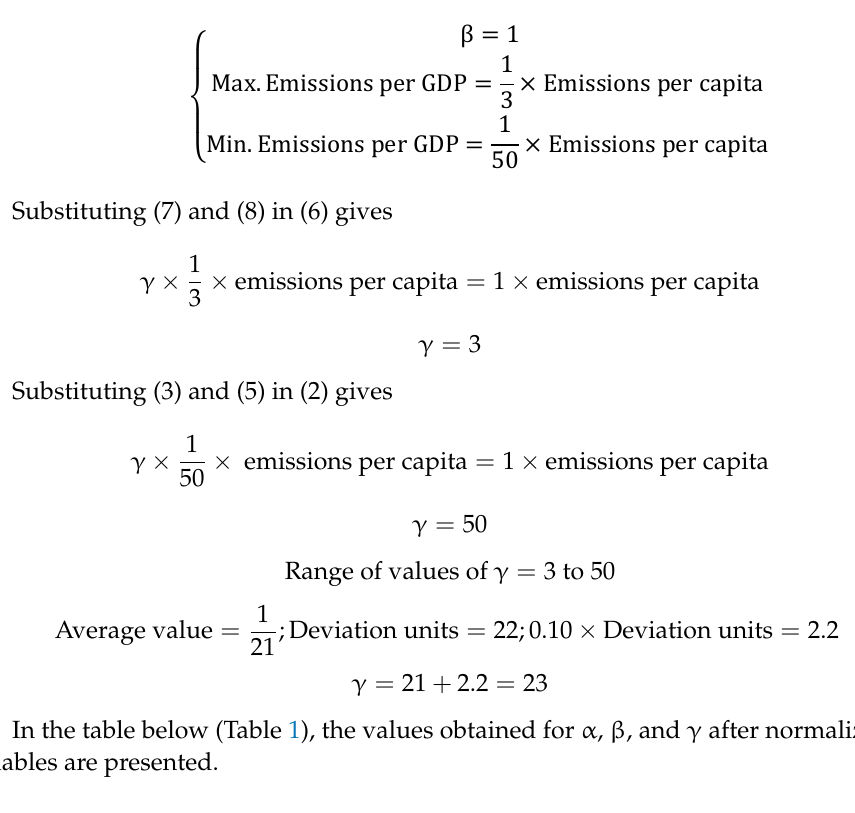
Table 1. Values of α , β , and γ after